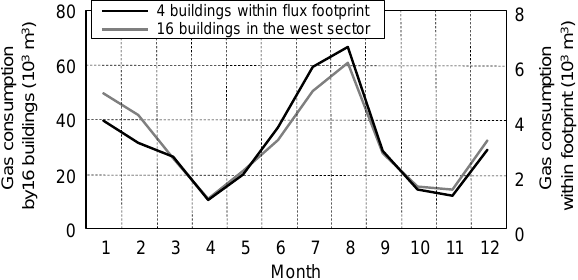
Figure A3. Seasonal variations in monthly gas consumption rates at Osaka Prefecture University for 2015. The data are shown for 16 buildings in the western sector of the university, where flux measurements were conducted, and for four buildings located within the flux